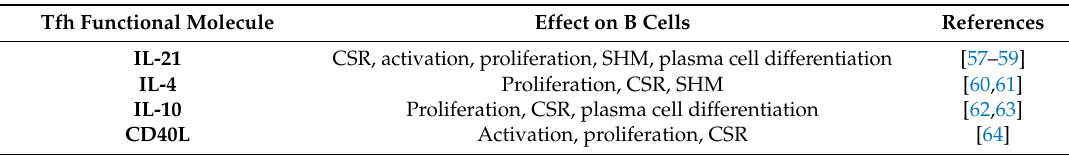
Table 2. Tfh mediators for B cell activation, differentiation and affinity